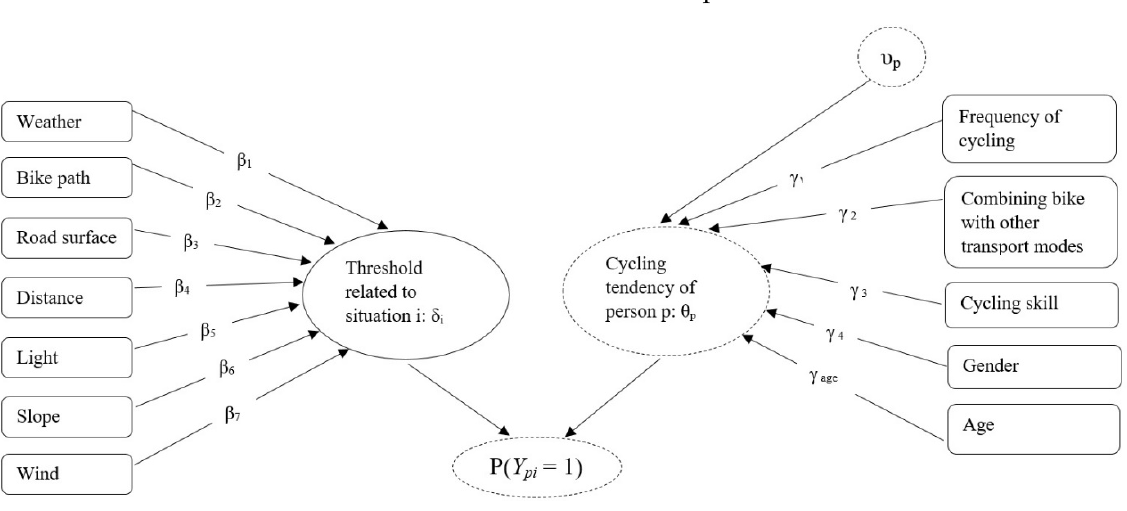
Figure 3. Graphical representation of the latent class